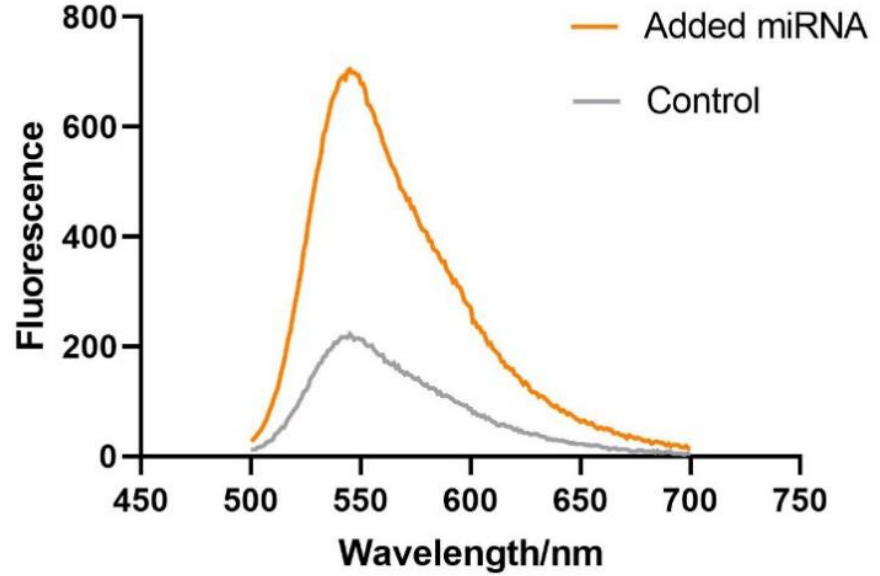
Figure 4. The feasibility assay of the detection method. Added miRNA: HP + miR-625-5p + KF polymerase + Nt.BbvCI + SYBR Gold; Control: HP + KF polymerase + Nt.BbvCI + SYBR Gold. The concentration of reagents above: HP (40 nM), miR-625-5p (100 nM), KF polymerase (5 U), Nt.BbvCI (20 U), SYBR Gold (1×).